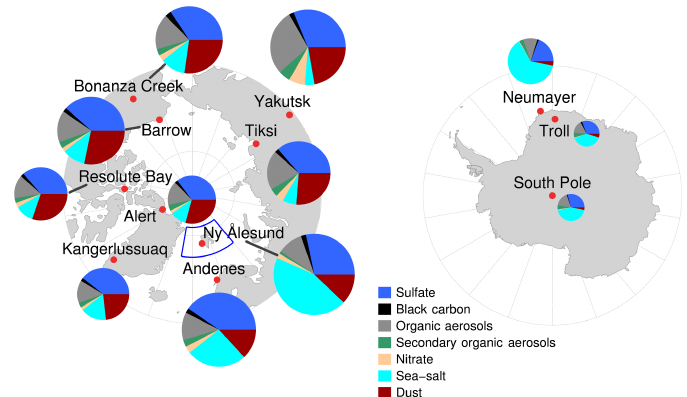
Figure 3. The locations of the stations (red dots) with AOD measurements used in this study and the MODIS area (blue square). The circles show the modelled AOD species MAM average for each station. The area of the circles is scaled to the model median total AOD.